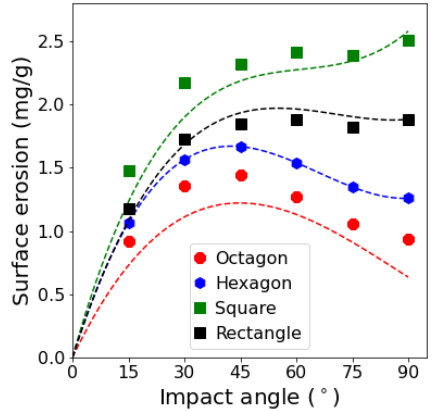
Figure 14. Comparison between the simulation results and the erosion estimations of the modified Oka’s model, Equation (37). The dashed lines represent the third order polynomials fitted to the simulation results shown in Figure 12 and dots are the erosion estimations of the modified Oka